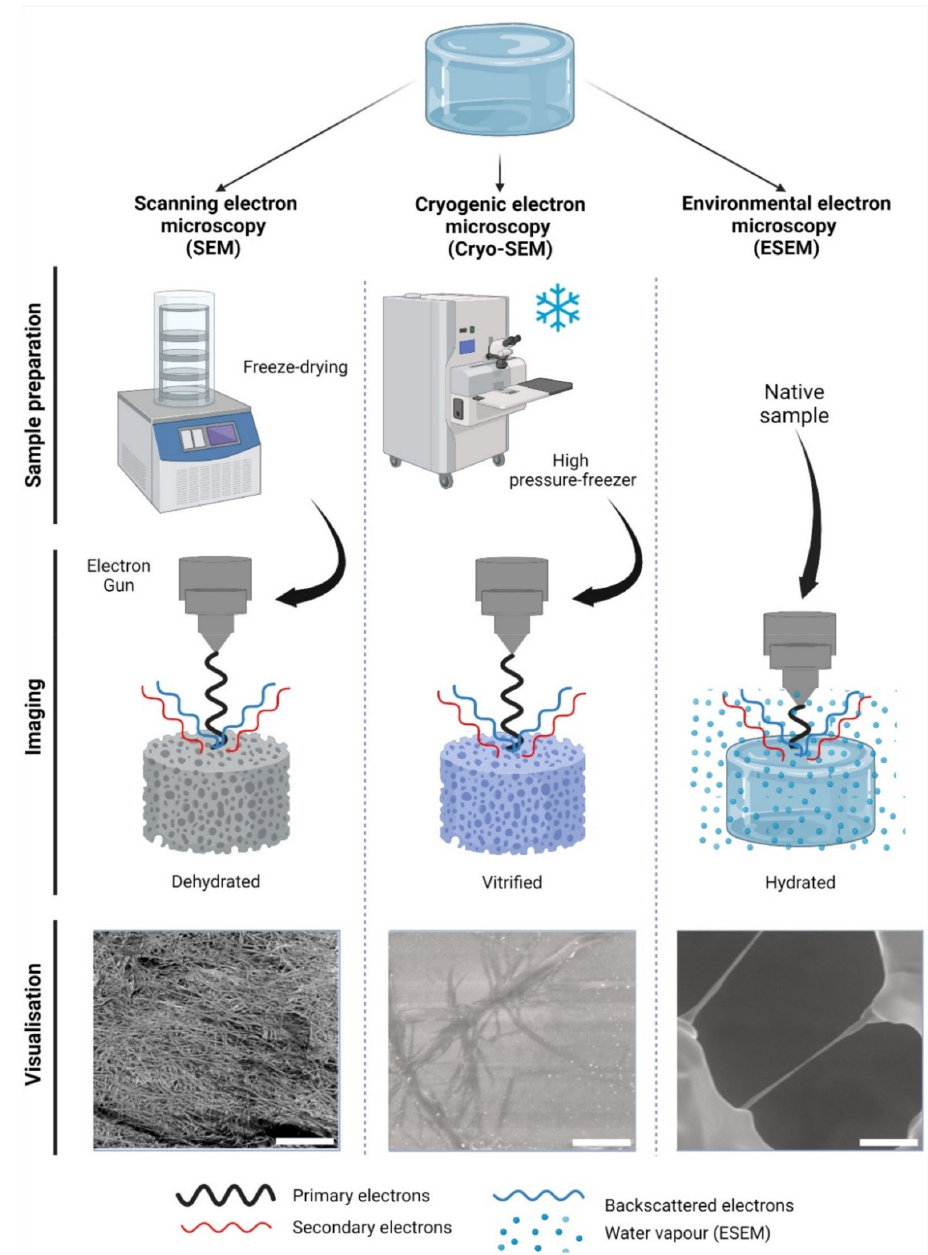
Figure 2. Electron-based imaging techniques for hydrogels. Standard scanning electron microscopy (SEM) relies on sample dehydration, including freeze-drying (shown) after fixation with aldehydes, followed by metal coating. Due to dehydration, the network appears condensed in visualization. In cryogenic SEM (Cryo-SEM), samples are vitrified using—among other methods—a high-pressure freezer (shown). Solid water ice is a source of imaging errors and is seen during imaging. In contrast, environmental SEM (ESEM) does not require a particular sample preparation, as it remains hydrated within a humidified chamber. In ESEM, the electron gun is closer to the specimen than in SEM or Cryo-SEM during imaging. As shown, single collagen fibers can be visualized; however, water condensation can cause imaging artefacts. The visualization of collagen type-I hydrogels (3.0 g/L) is shown at 12,000 ˆ magnification, 5 kV, and z = 9 mm. Scale bars represent 5 µ m. Collagen type I hydrogels preparation, SEM, Cryo-SEM and ESEM detailed in Appendix